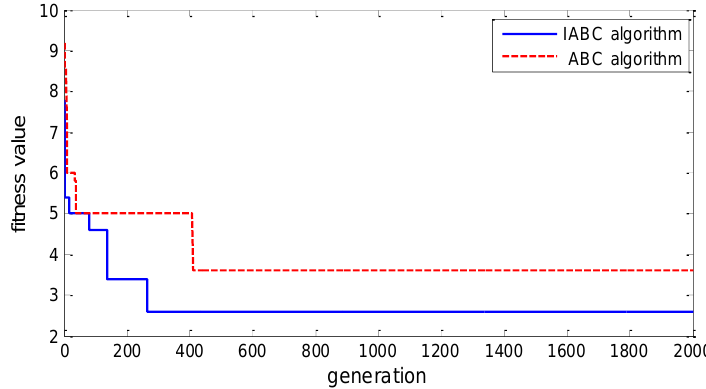
Figure 10. Fitness curve.